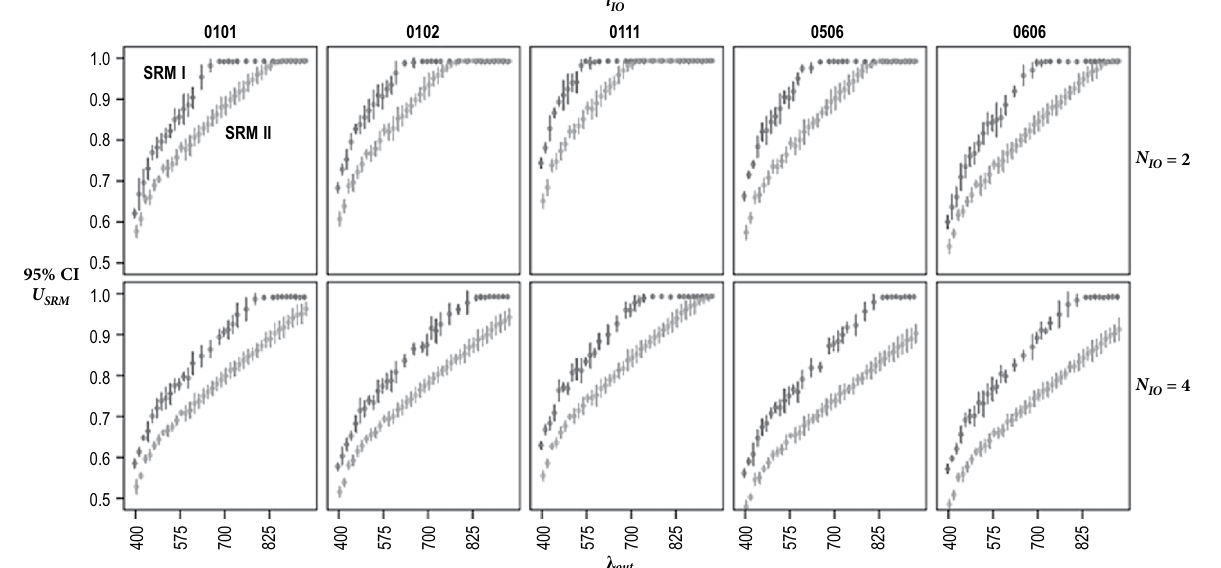
Fig. 7. 95% CI of the mean